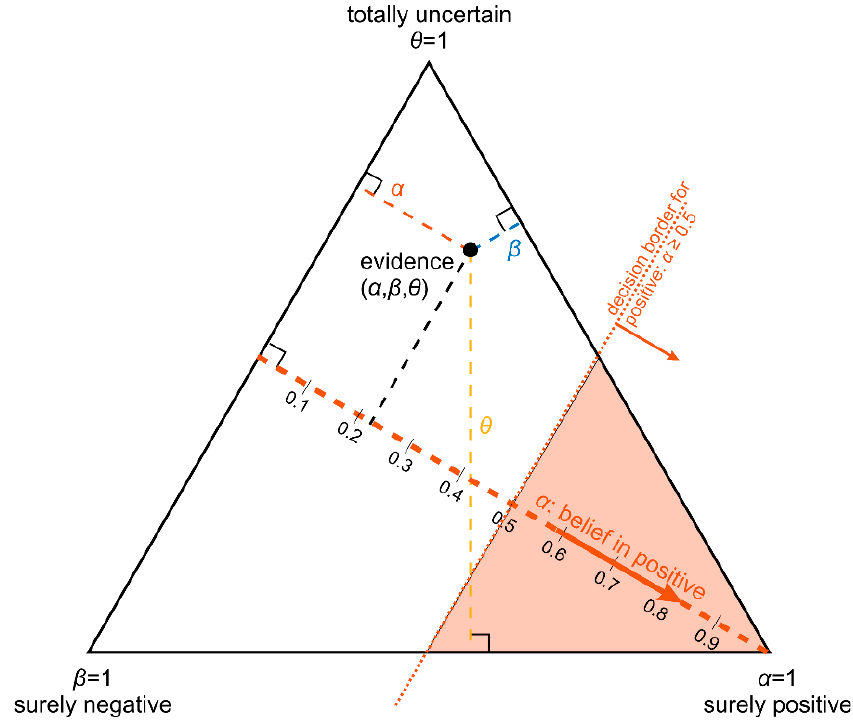
Figure 5. Principles of a ternary plot: obtaining coordinates by the altitude method. Decision border α ≥ 0.5: ‘positive to the best of our knowledge’ or ‘positive is more likely than anything else’. Each of the three components of evidence, e.g., α , the ‘belief in positive’, has its own scale, see the dashed heavy line in orange; it starts on the left with α = 0 at a right angle from a triangle’s left side and runs towards the opposing corner, where α = 1 (indicating ‘surely positive’). See also the scale with numerical values aside. The two other scales, for β and θ , are defined analogously (not shown for